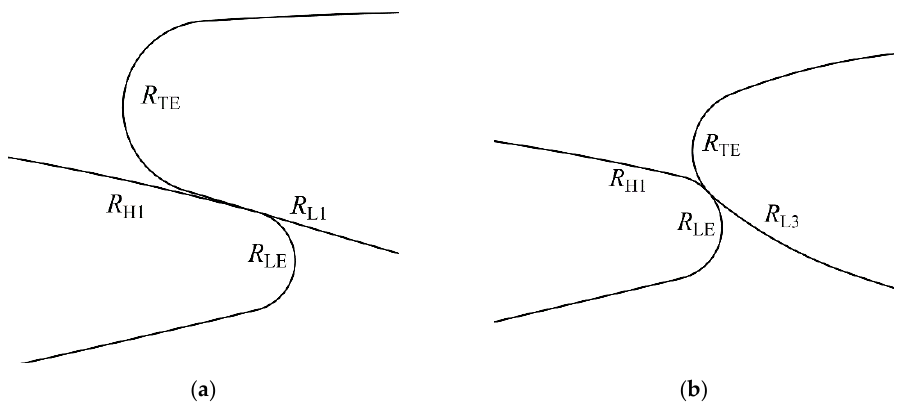
Figure 5. Overlapping shapes of GV airfoil. ( a ) GV-O; ( b ) GV-M. Table 2. Main geometric parameters of GV airfoil shape against R LE-O .